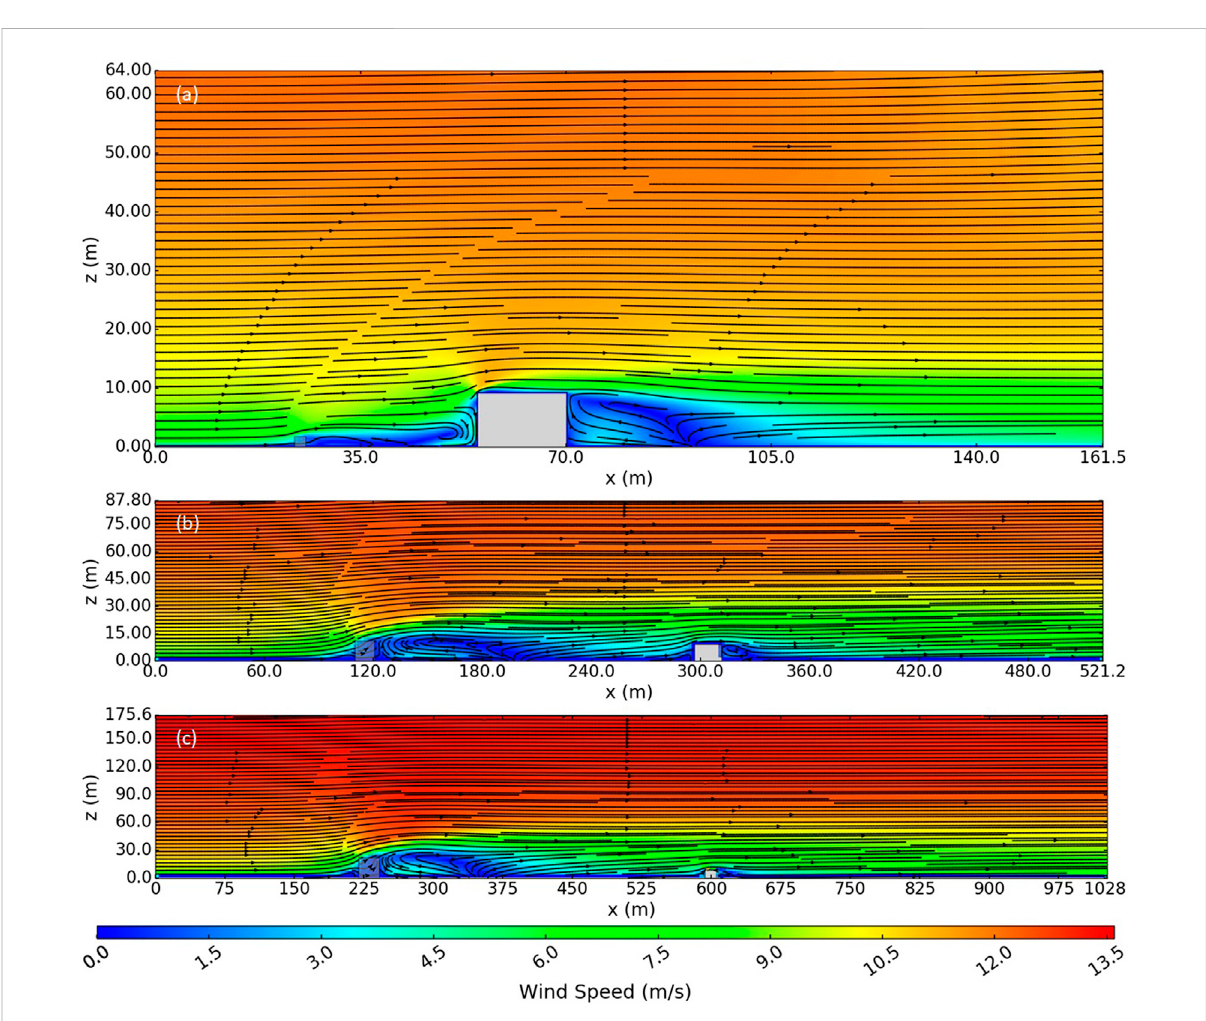
FIGURE 9 Side view slice down the middle of the domain of the simulated wind fi elds for various fence heights with both the fence and house present in the fl ow. Fence heights of (A) 1.8 m, (B) 11 m, and (C) 22